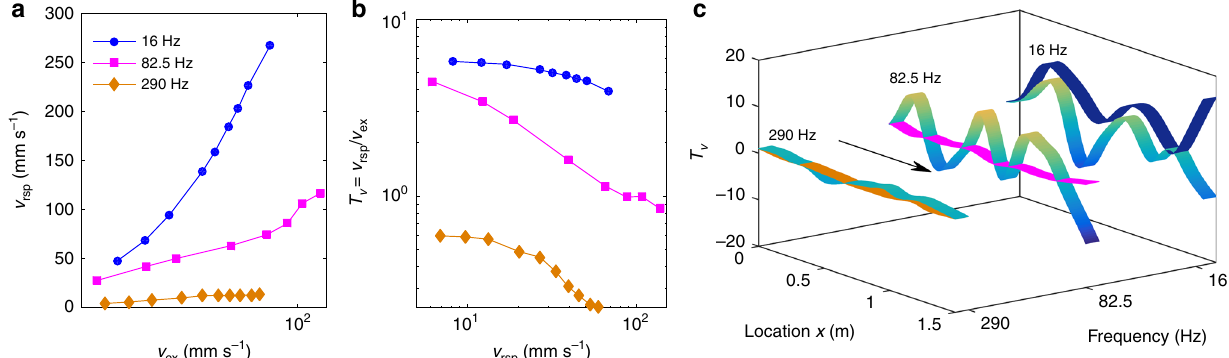
Fig. 4 Steady responses and wave modes of the NAM beam. a v rsp and b T v as a function of v ex ; the horizontal axes are logarithmic scales. c Generalized wave modes of the whole beam under a small excitation (0.3 V, linear regime, shown by the rainbow colors) and a large excitation (5 V, strongly nonlinear regime, shown by the deep blue (16 Hz), magenta (82.5 Hz) and yellow (290